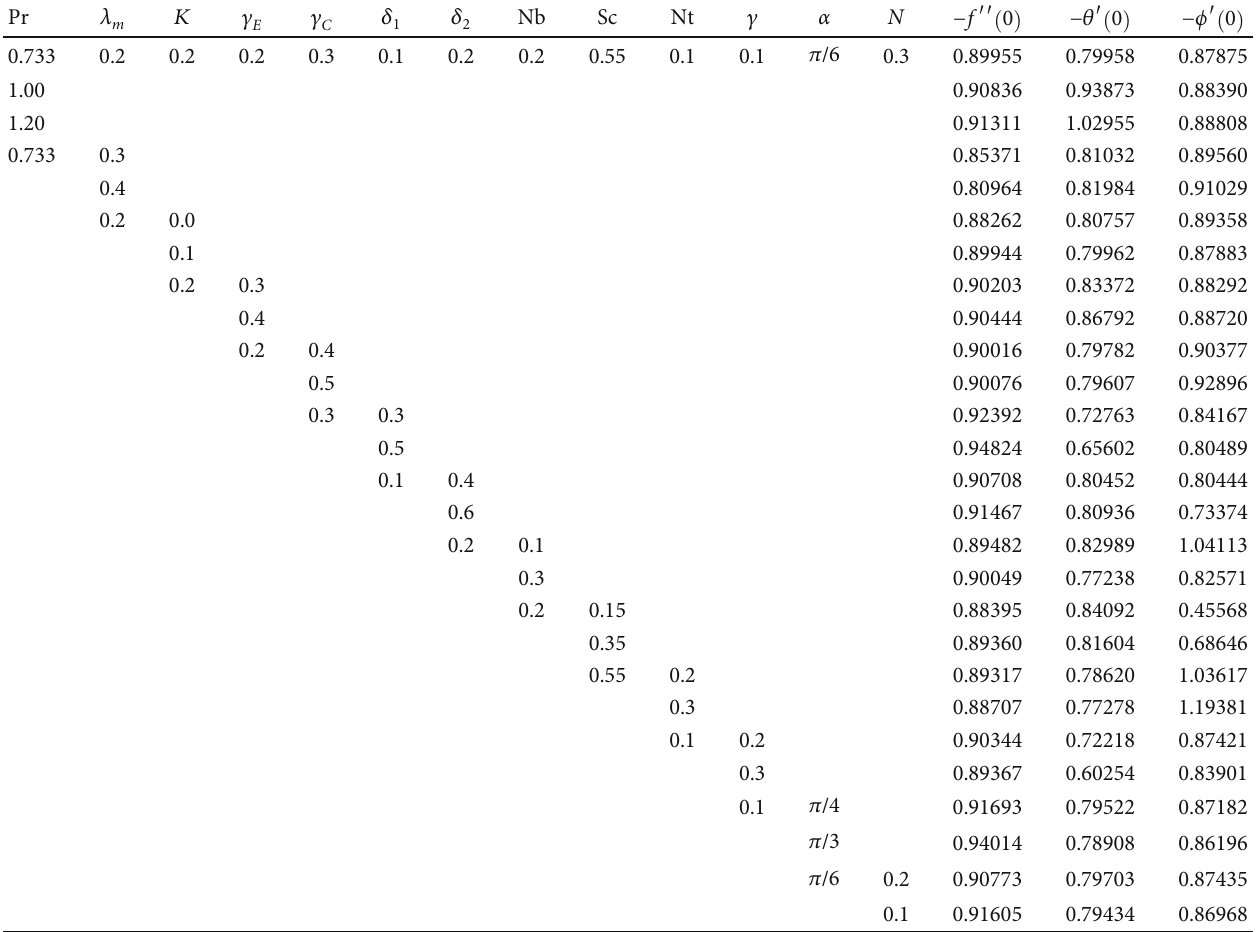
Table 5: Numerical values of local skin friction coe ffi cient − f ′′ ð 0 Þ , local Nusselt number – θ ′ ð 0 Þ , and local Sherwood number − ϕ ′ ð 0 Þ .